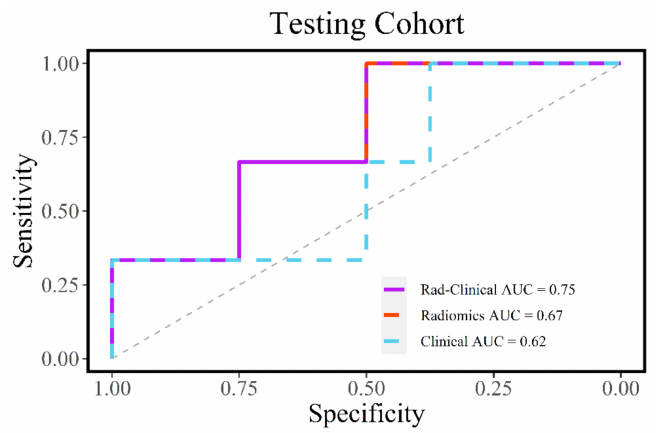
Figure 3. Receiver operating characteristic (ROC) curve analysis for the radiomic, clinical, and combined models in the testing cohort. The combined model performed the